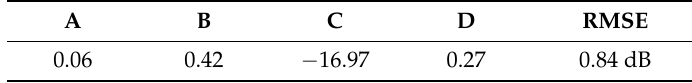
Table 2. Water Cloud Model parameters for the VV